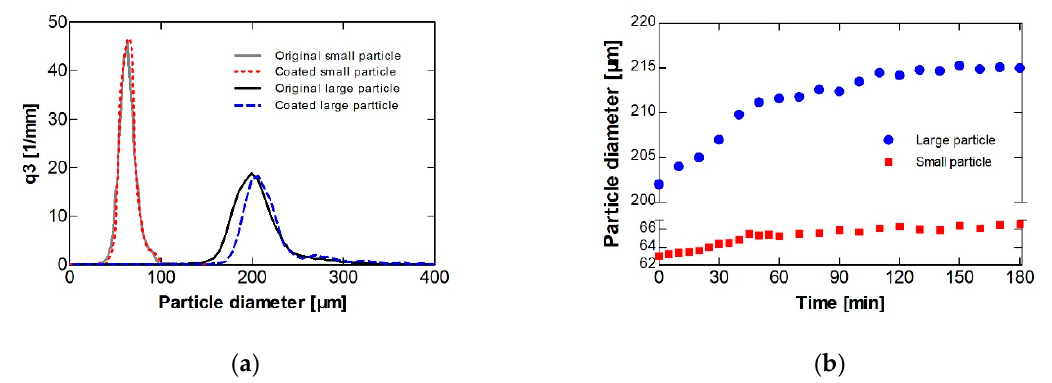
Figure 7. ( a ) Particle size distributions, and ( b ) evolution of average particle diameter d 1,3 for particles of different size.